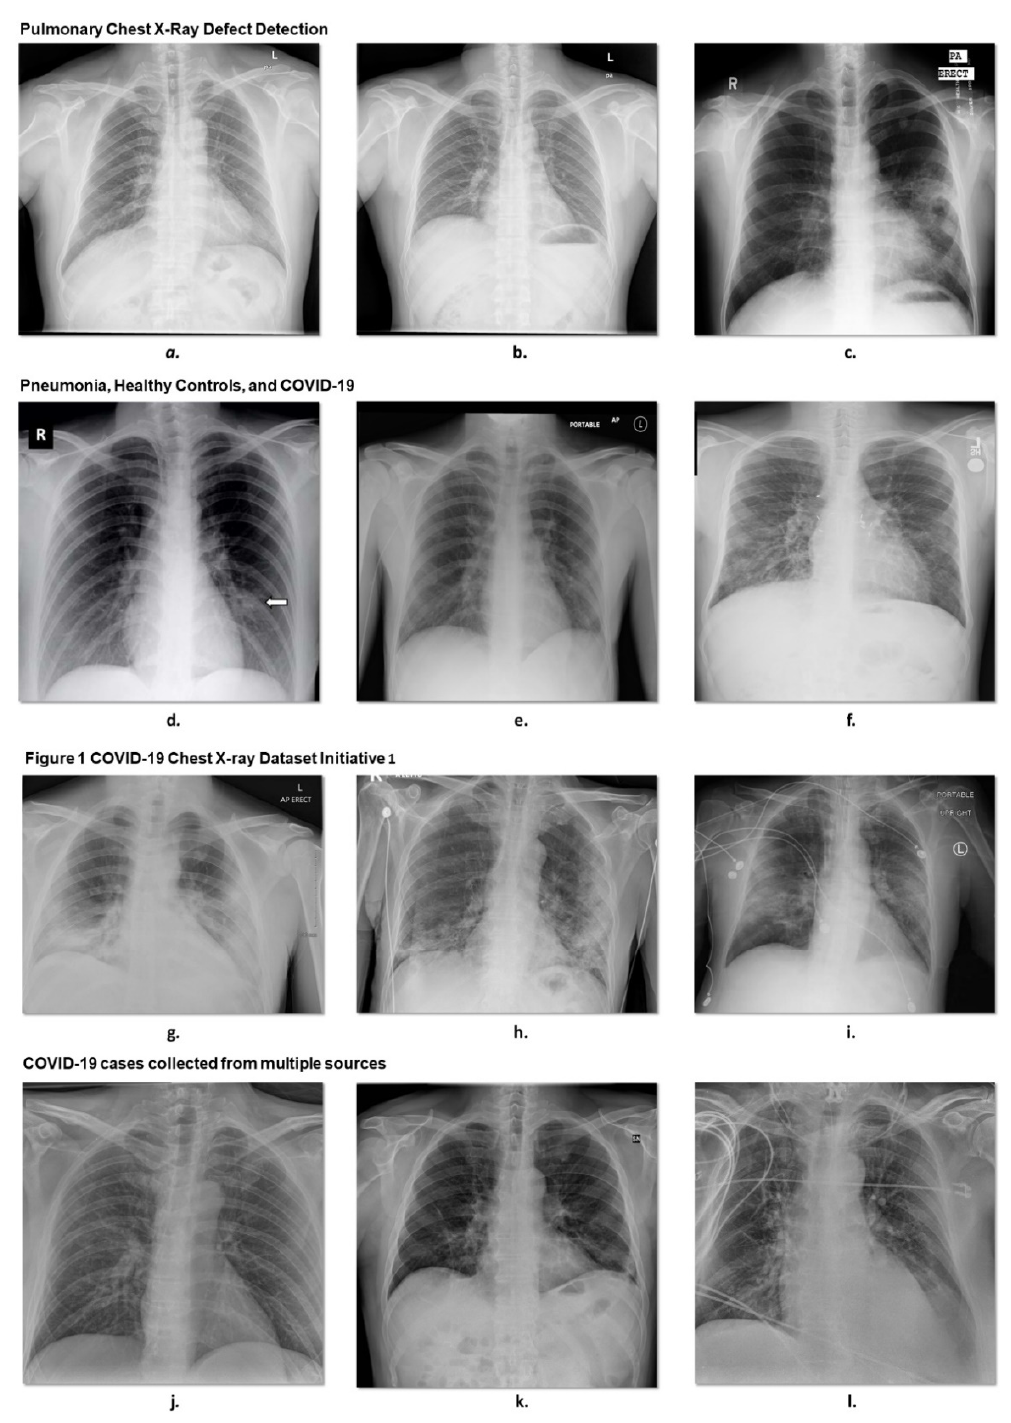
Figure 3. Some examples of CXR images for each dataset are presented: ( a – c ) are our 704 cases of training set taken from the Shenzhen set; ( d – l ) images are used to independently validate our system.